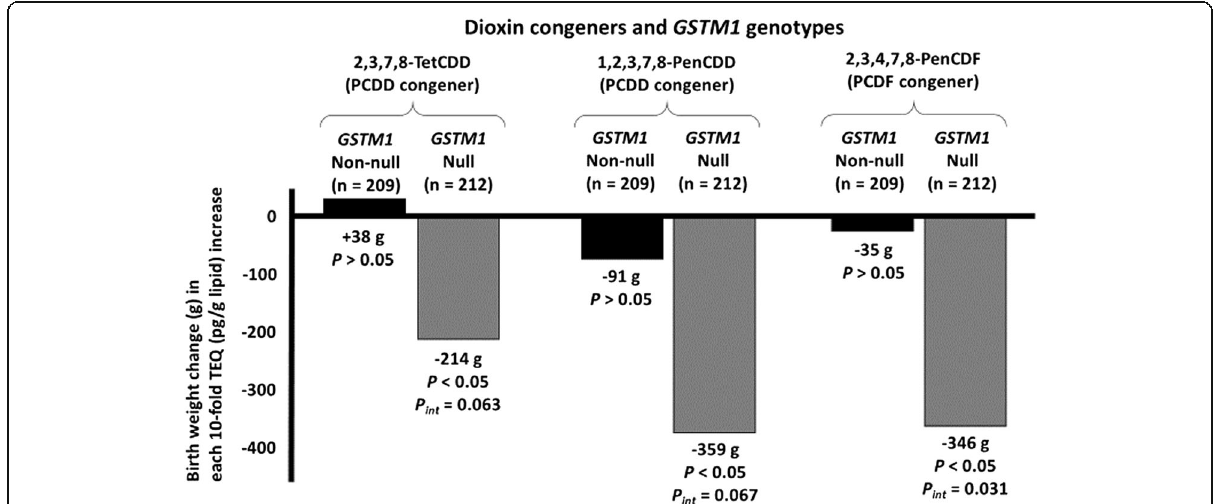
Fig. 1 Association of maternal PCDD and PCDF congeners and maternal GSTM1 (non-null/null) genotypes with reduction of infant birth weight in the multiple linear regression model ( N = 421)